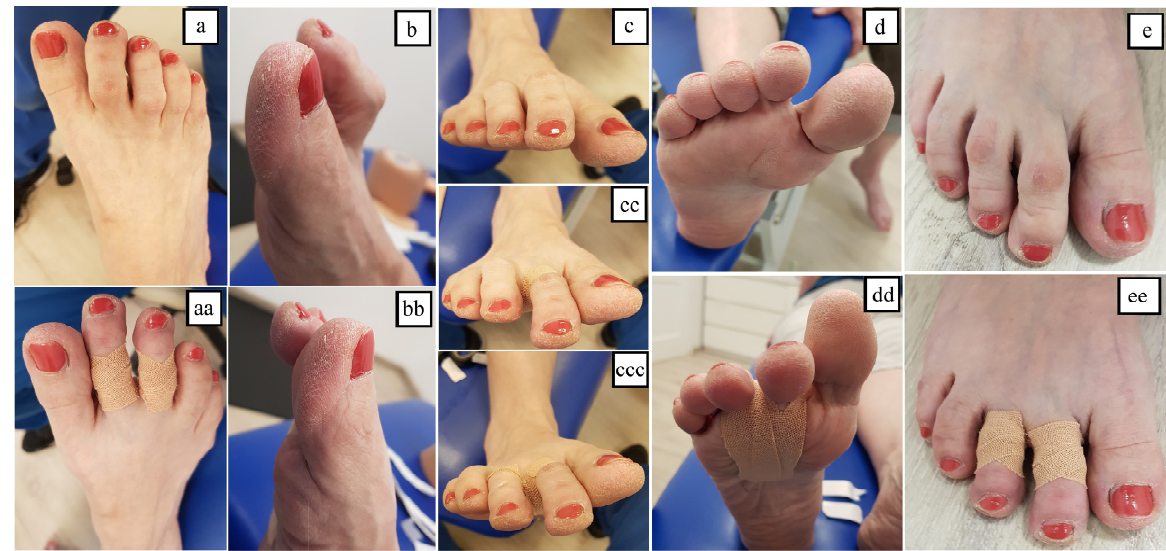
Figure 1. Hammertoes on right foot: dorsal ( a ), lateral ( b ) anterior ( c ), plantar ( d ) and standing ( e ) views. Hammertoes after KT application: dorsal ( aa ), lateral ( bb ), anterior—after application on second ( cc ) and third toe ( ccc ), plantar ( dd ) and standing ( ee ) views.